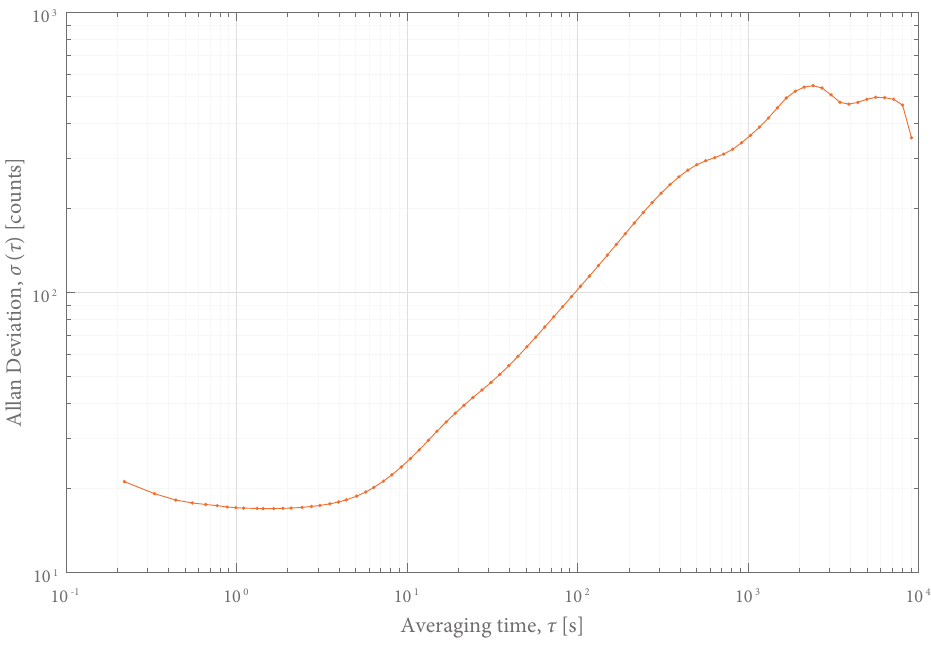
Figure 10. Allan deviation The brief decline at the onset of the curve indicates that the contribution of white noise is relatively small. The upward slope shows that the sensor response is dominated by drift. It can be concluded that the optimal averaging time is around 2